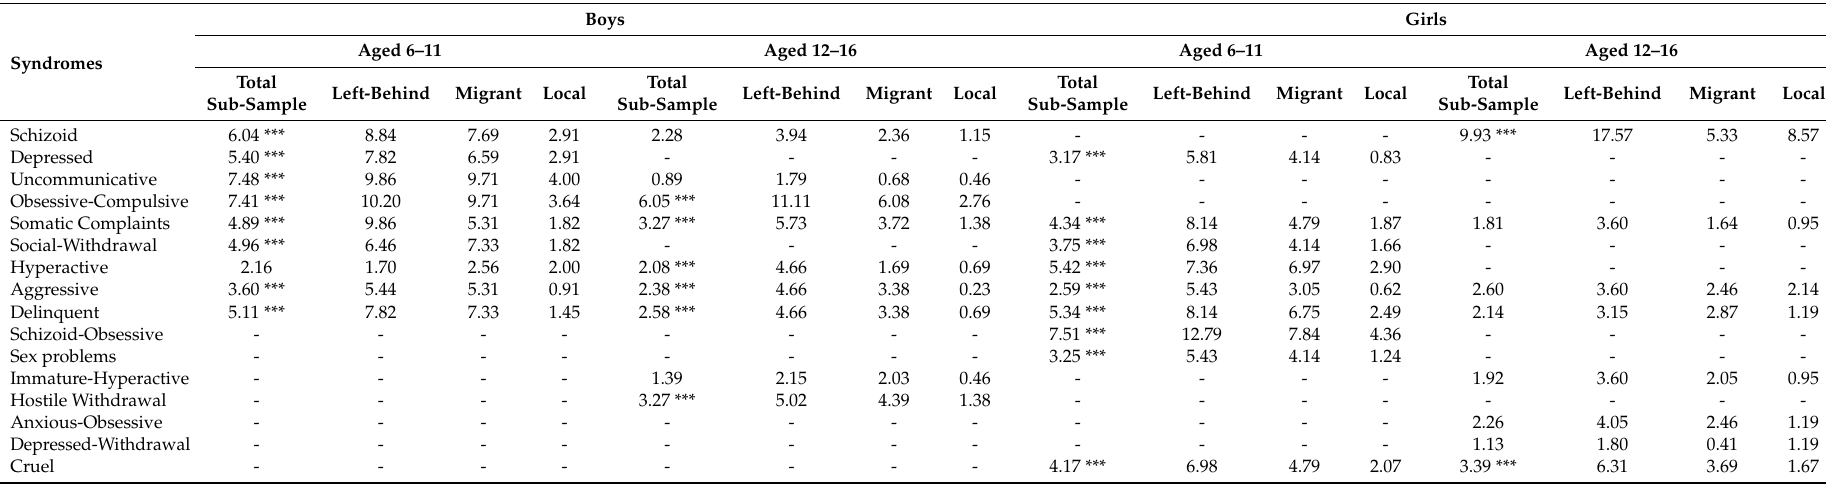
Table 4. Prevalence of specific syndromes of behavioral problems among left-behind, migrant and local children (%).